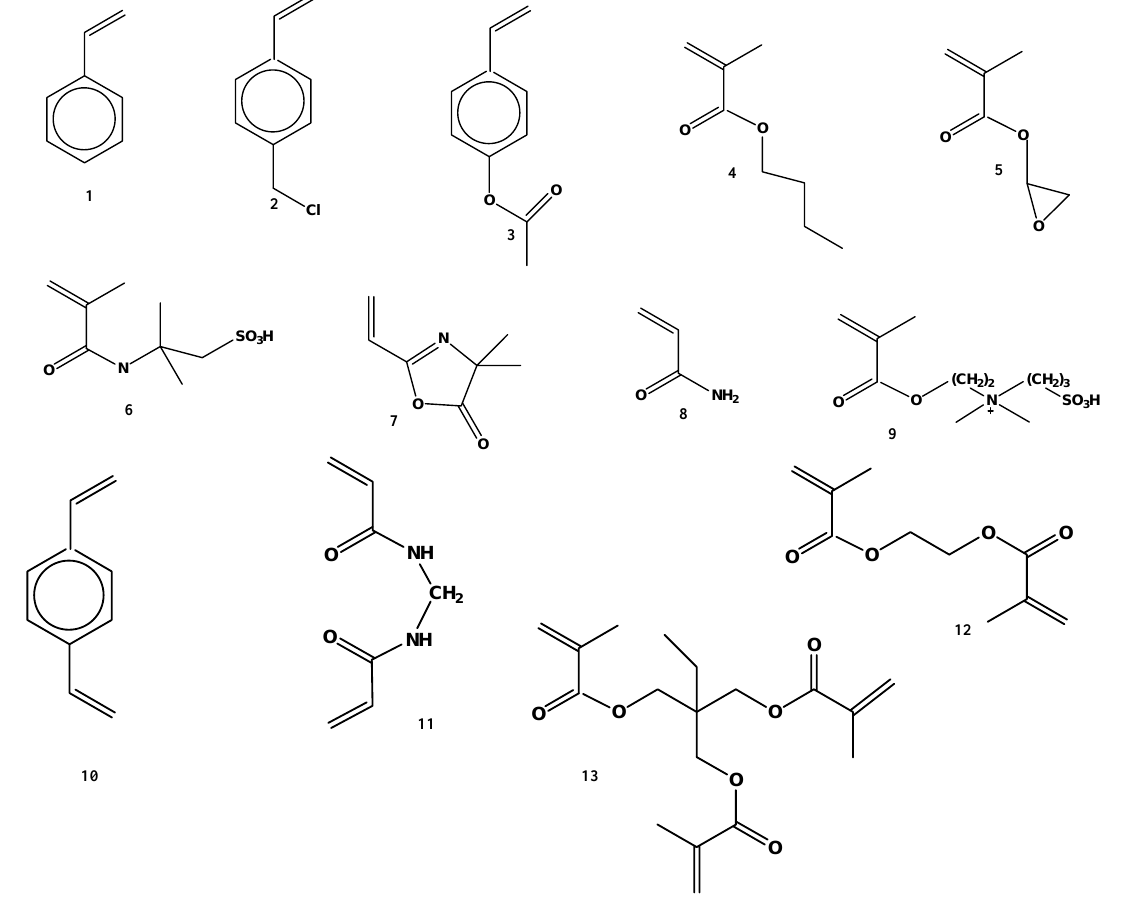
Figure 5. Monovinylic monomers and cross-linkers used in the preparation of porous polymer